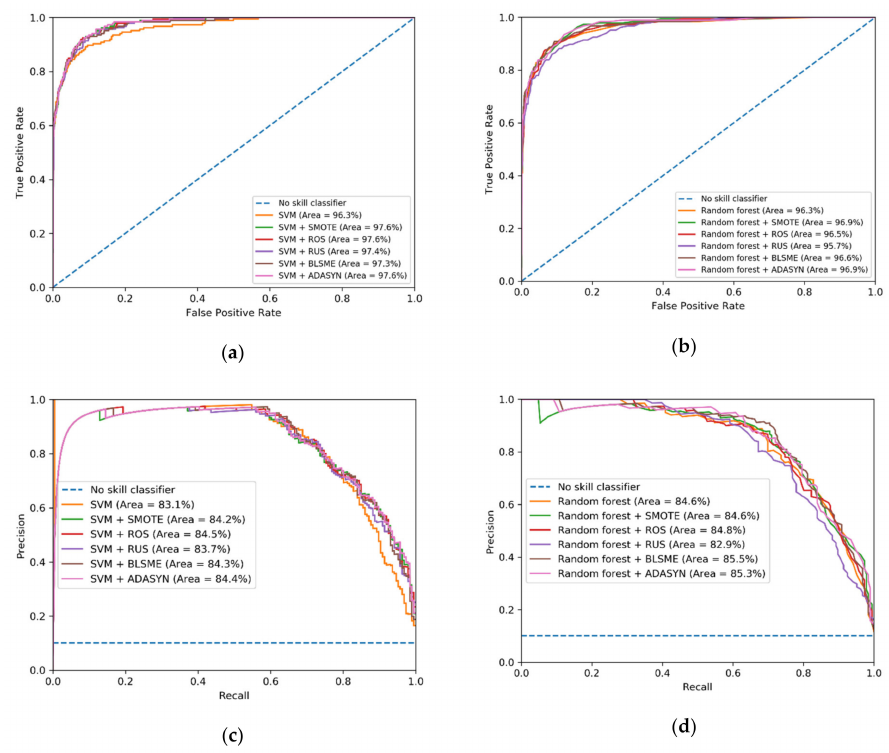
Figure A2. The ROC and PR curves of SVM and Random Forest for Fold 1; ( a ) the ROC curve of SVM; ( b ) the ROC curve of Random Forest; ( c ) the PR curve of SVM; and, ( d ) the PR curve of Random Forest.